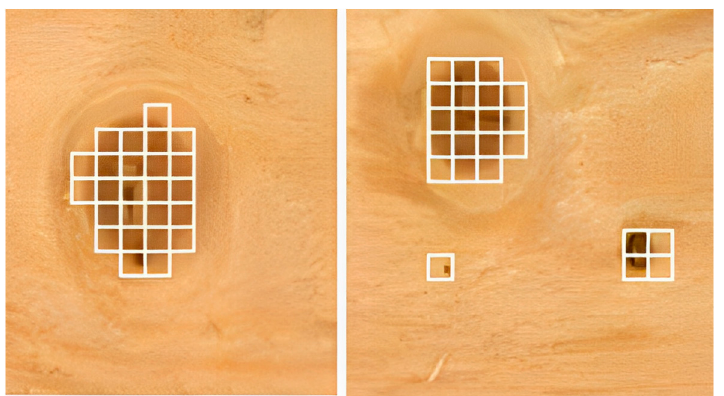
Figure 2. An example of the result of wood defect detection using the presented technique in [2].